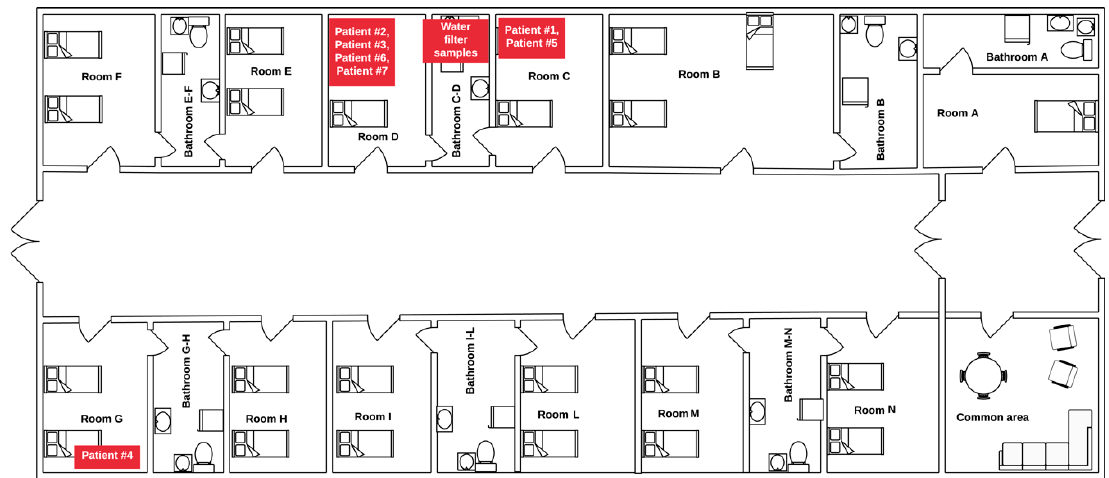
Figure 1. Floorplan of the hematology unit. Six of the reported cases clustered around rooms D and C, which share a bathroom where environmental isolates were collected. One case was detected in a patient from room G.